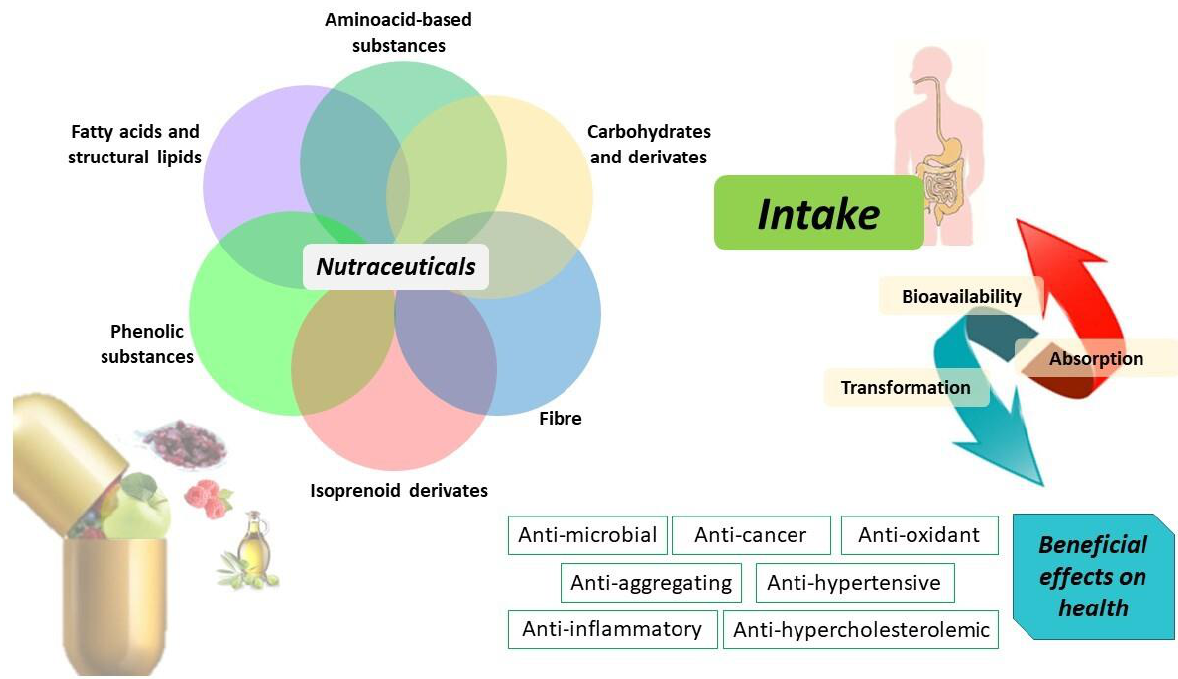
Figure 1. Nutraceuticals and their biotransformation improving human health.